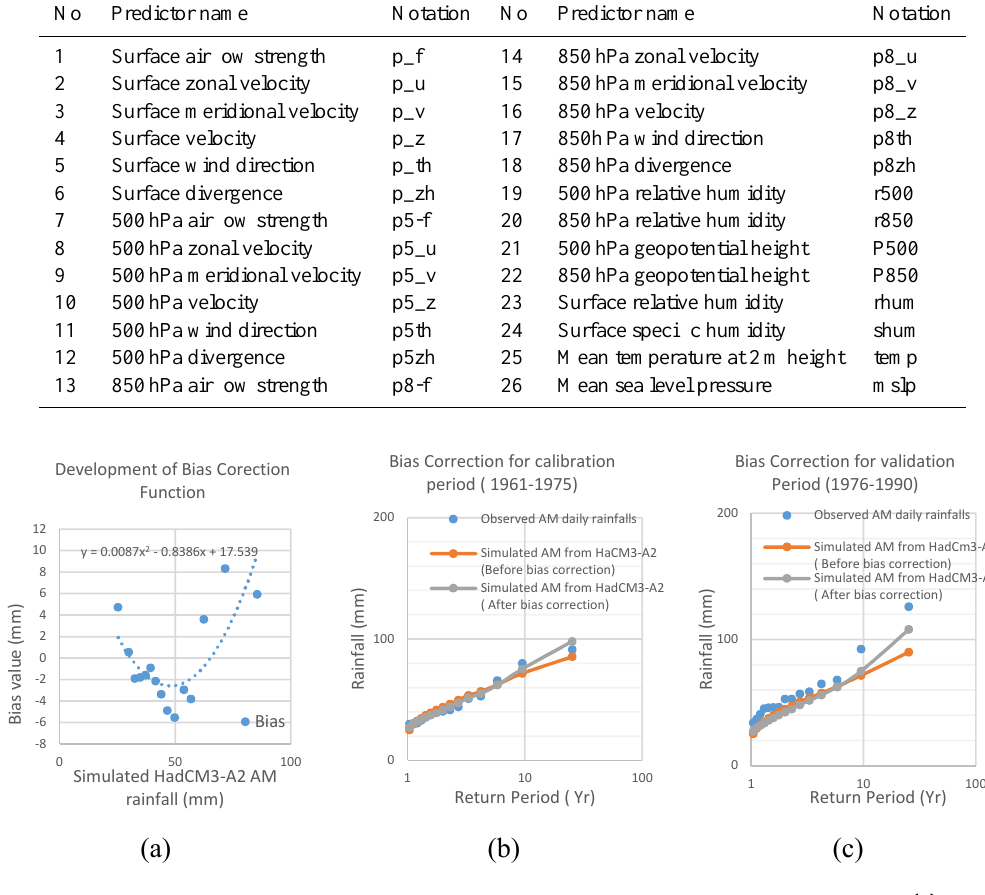
Figure 2. Illustration of proposed bias correction by applying to Canberra airport comparison rain gauge station. (a) Development of bias correction for calibration period of 1961–1975, (b) assessing of proposed bias correction for calibration period (1961–1975) and (c) assessing of proposed bias correction for validation period